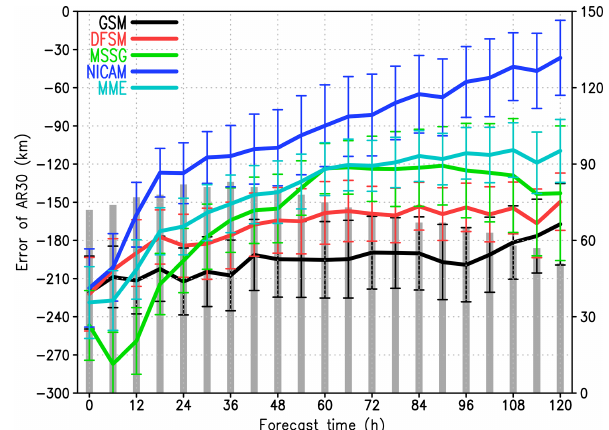
Figure 5. Errors in the averaged radius of the 50-knot wind (AR50) for GSM, DFSM, MSSG, NICAM and MME (in the second stage). Each grey bar indicates the number of samples at each forecast time (right-vertical axis). Error bars indicate 95% confidence levels of the AR50 difference between the prediction and the RSMC Tokyo best-track data.